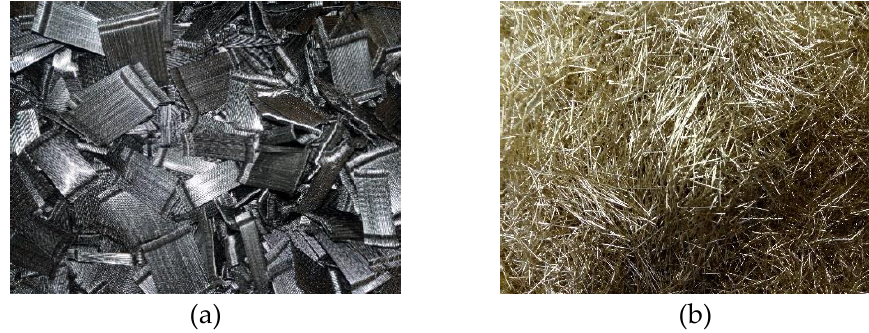
Table 1. General characteristics of fibers.